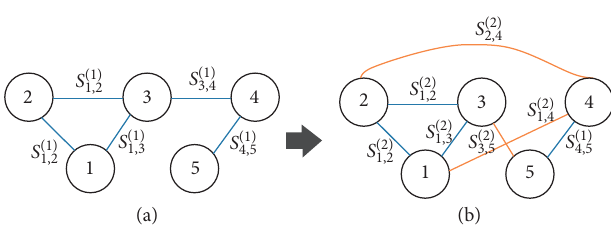
Figure 6: Construction of first- and second-order weight proximity networks. (a) First-order proximity network (original network). (b) Second-order proximity network. The latter is constructed on the basis of the former network. In (b), blue edges denote edges common to first-order networks, and yellow edges denote edges unique to second-order